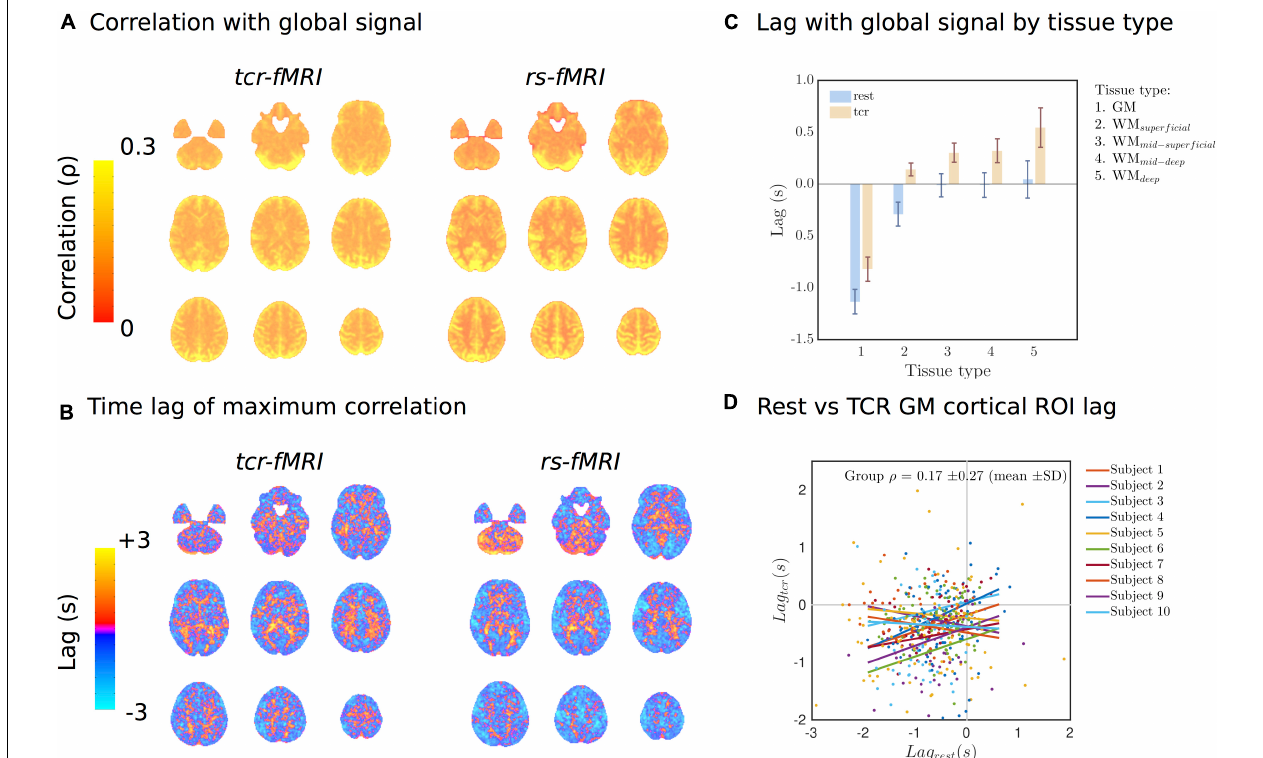
FIGURE 5 | (A) Lag-adjusted correlation with the GS images for both conditions. (B) Lag time of the maximum correlation with the GS images. (C) Average lag time of the maximum correlation with the GS by tissue type. (D) Individual subject scatter plots of the Harvard-Oxford cortical ROI averaged lag times in Rest vs. TCR condition. Individual subject regression lines are included.